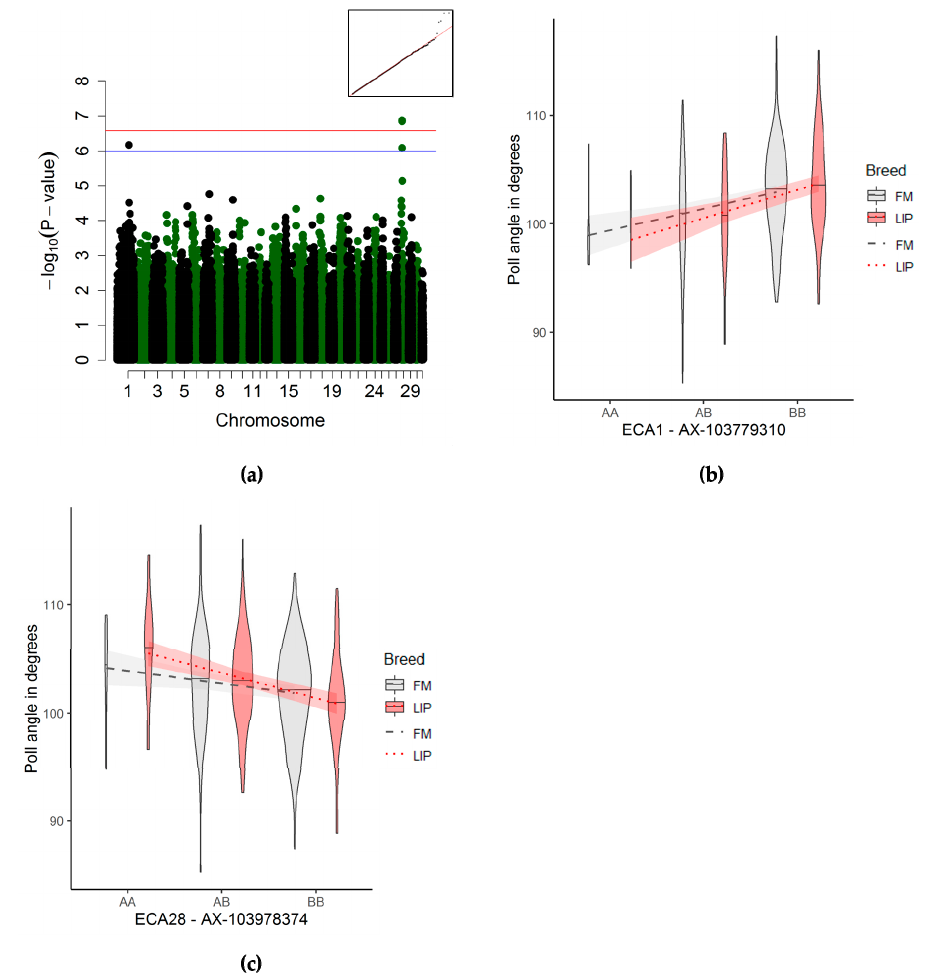
Figure 2. Genome-wide association study (GWAS) for the poll angle ( n = 495). ( a ) Manhattan plot (blue line) representing the suggestive significance threshold ( p < 10 − 6 ) and (red line) the significance threshold corrected for the e ff ectively independent single nucleotide polymorphisms (SNPs) (p Ind <2.66 × 10 − 7 ). The inset on the right-hand corner shows the quantile–quantile (Q–Q) plot with the observed plotted against the expected p -value. (b,c) Violin plots and trend lines (standard error in translucent) representing the genotype effect of the SNP on ECA1 (b) and ECA28 (c) on the poll angle. The red colour (and dotted line) represent the Lipizzan (LIP) sample; the grey colour (and dashed line) represents the Franches-Montagnes (FM) sample. The width of the violin plot represents the number of